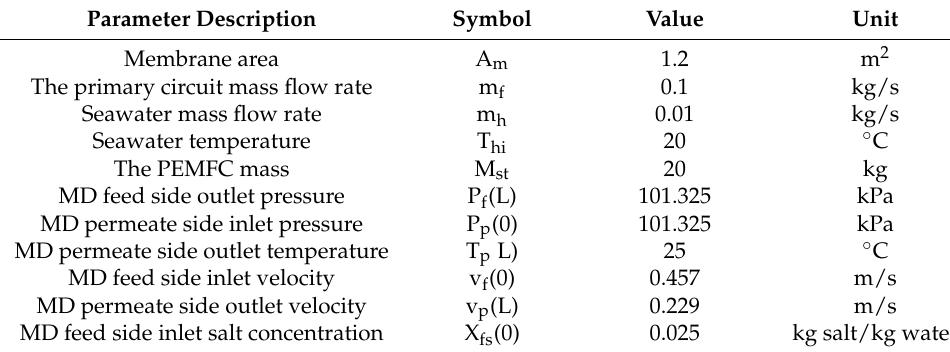
Table 7. The operating conditions for both